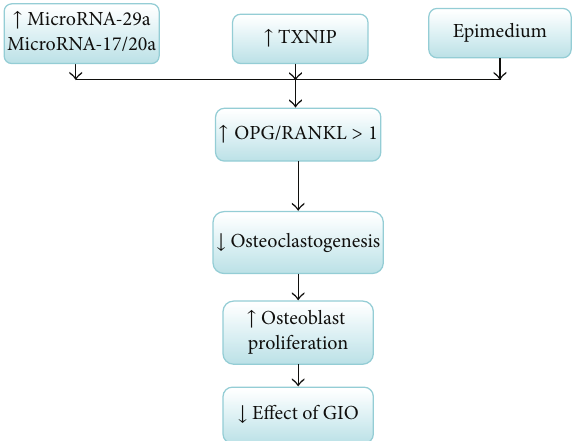
Figure 2: The protection mechanism against glucocorticoid-in- duced osteoporosis. MicroRNA-29a and microRNA-17/20a can inhibit osteoclastogenesis and promote osteoblast proliferation. Ep- imedium, which is the Chinese patent medicine, can antagonize the abnormal expressions of OPG and RANKL mRNA. The gene encod- ing TXNIP may increase the ratio of OPG/RANKL to downregulate osteoblast-mediated osteoclastogenesis. These potential protection mechanisms can prevent the progression of GIO and can provide a feasible and effective guidance to the treatment of osteoporosis after transplantation. The upward arrows show promoting effect; the downward arrows show lessening or inhibitory effects.